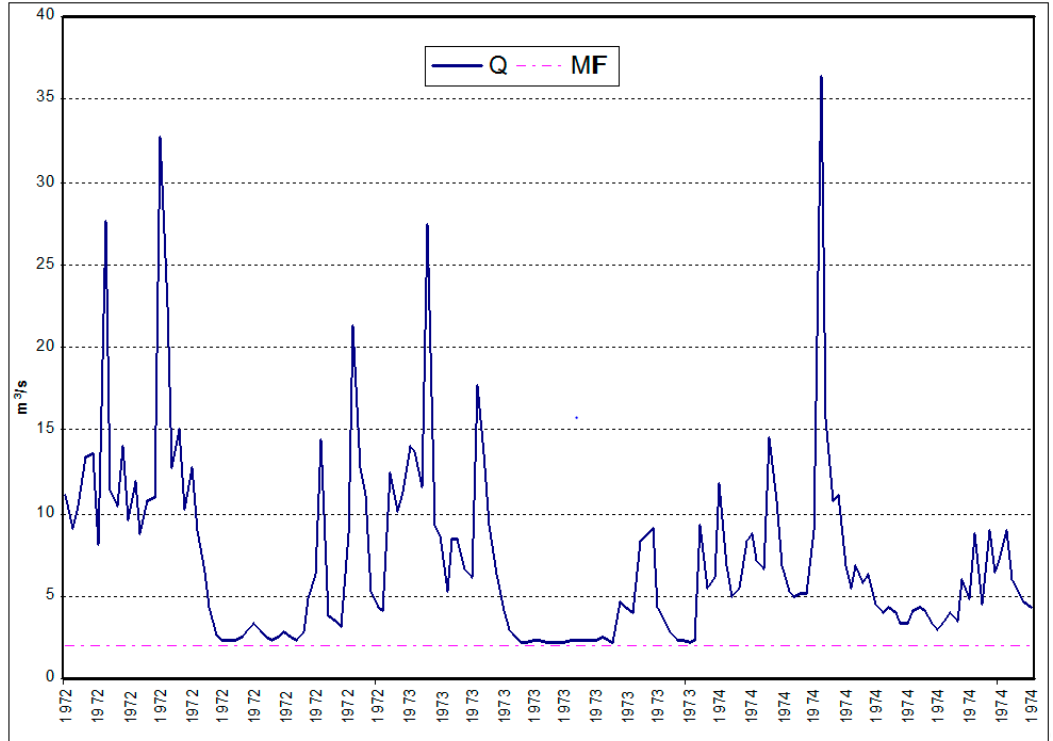
Figure 6. S. Lucia control node, discharge and MIF in scenario